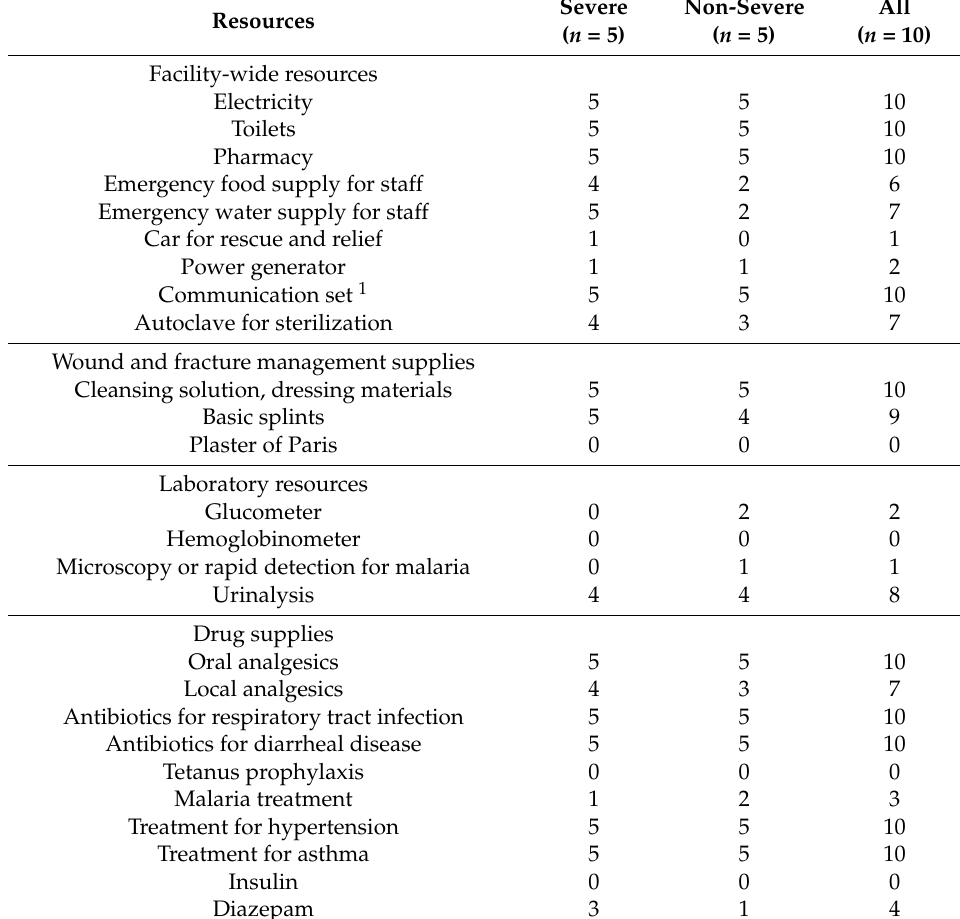
Table 3. Availability of observable resources at severely and non-severely flooded primary health care